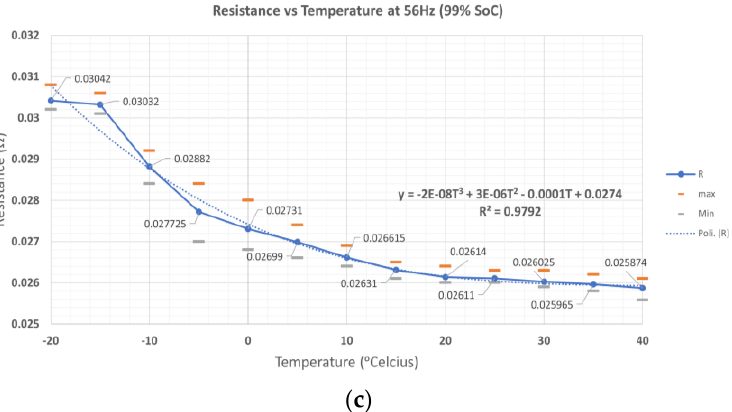
Figure 12. Curve fitting polynomials and mean batteries’ impedance data: ( a ) at 20%; ( b ) at 50%; ( c ) at 99% SoC level.